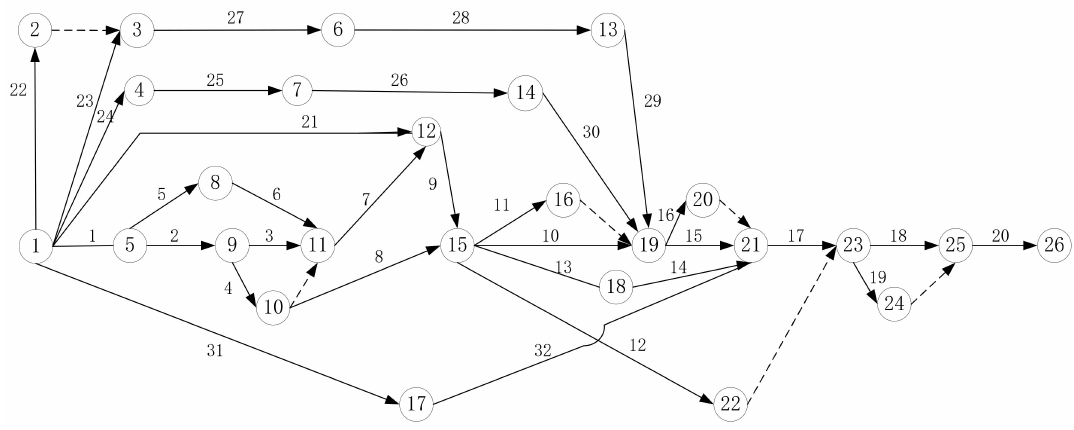
Figure 3. Double code network diagram of the construction of a concrete face rock fill